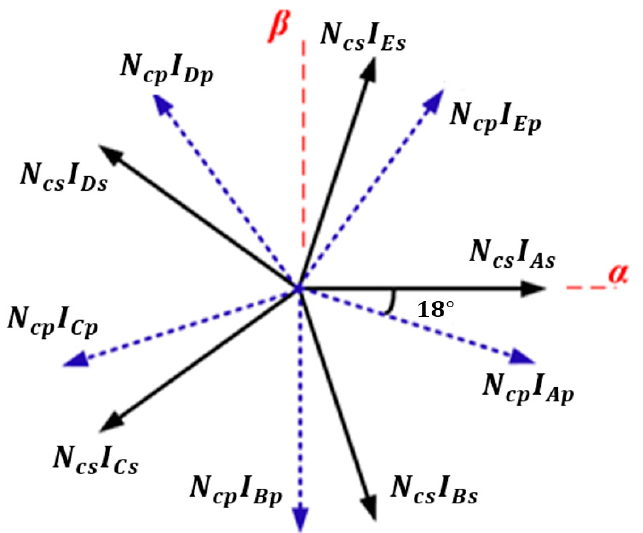
Figure 3. Phasor diagram of the MMF magnitude in combined star–pentagon winding.